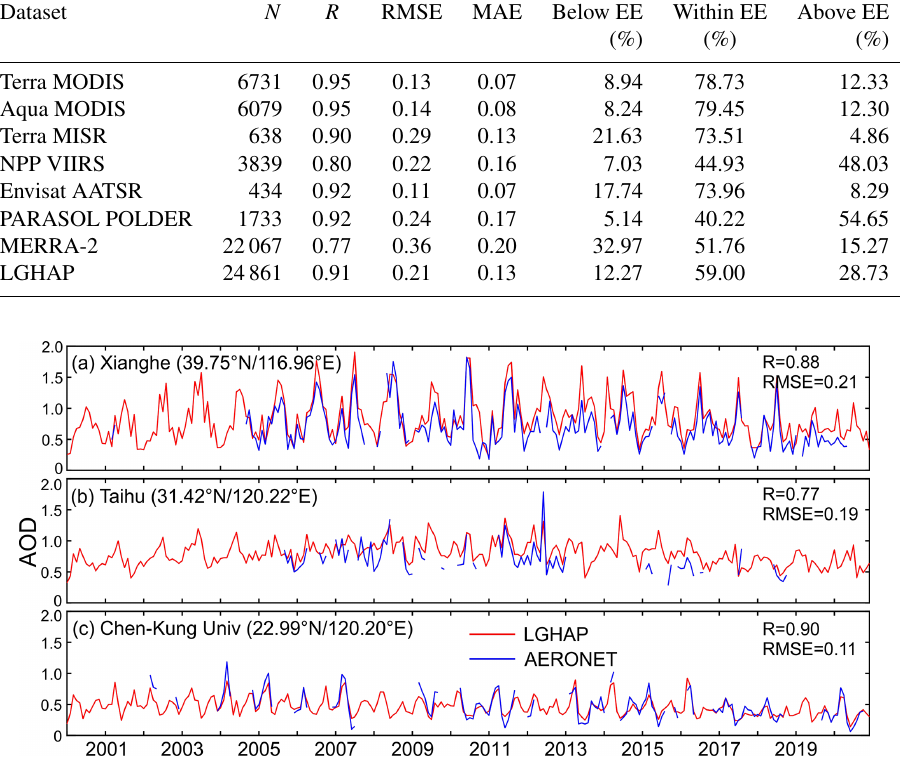
Figure 3. Comparison of monthly AOD time series from LGHAP and AERONET at three different stations in China. Latitude and longitude information of each site is given in